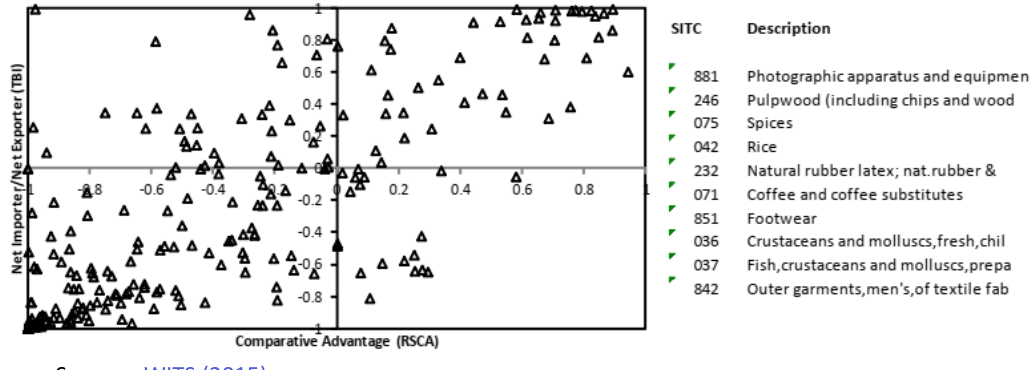
Figure 19: Products Mapping and the Top-Ten Export Products of Vietnam, 2014 Vietnam. In 1997, four among the top-ten export products of Vietnam’s are from the manufacturing sector (secondary), i.e.: footwear 9851), outer garments, textile (842), travel goods, handbag, brief-case (831) and silk (261). The rest are from primary sector. Vietnam’s 2014 top-ten are like 1997, which is half of it come from secondary